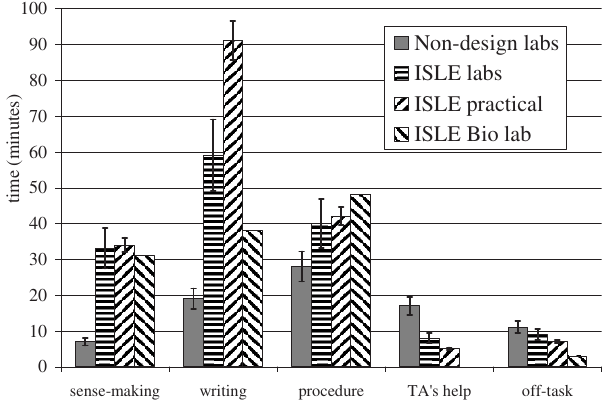
FIG. 1. Time spent on different activities (cid:1) in minutes (cid:2) . The data are averaged over the sample. The error bars show the standard deviations of the data sets for the observed groups.